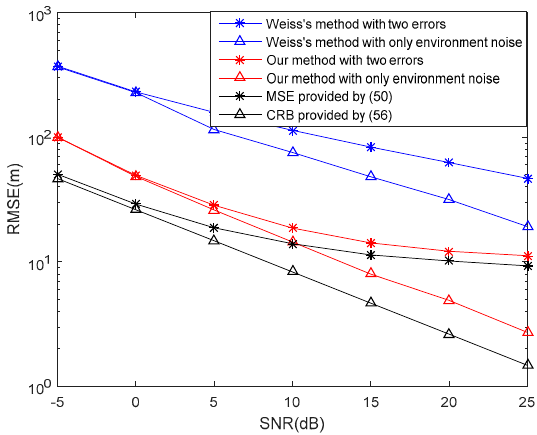
Figure 5. RMSEs versus SNR under different scenarios.